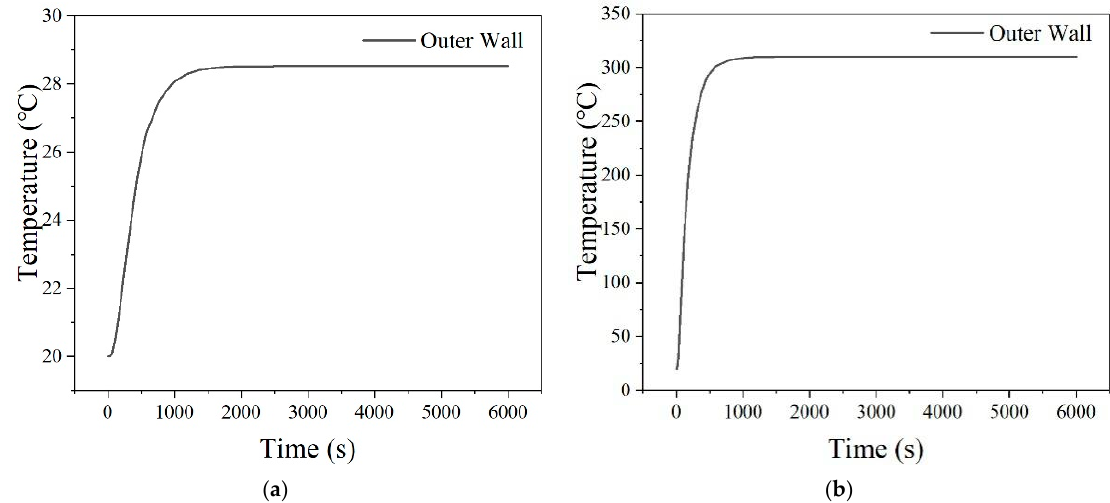
Figure 12. Temperature response of the outside point of the evaluation paths. ( a ) Section A. ( b ) Section B.